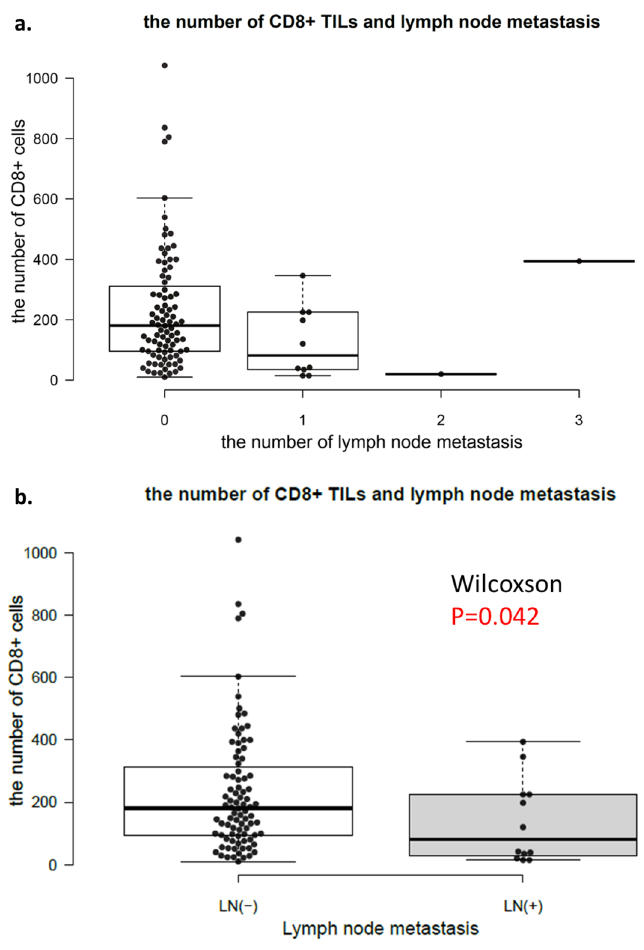
Figure 3. ( a ) The number of CD8 + TILs and lymph node metastases from SM-CRC. ( b ) The number of CD8 + TILs and presence of lymph node metastasis from SM-CRC ( P =